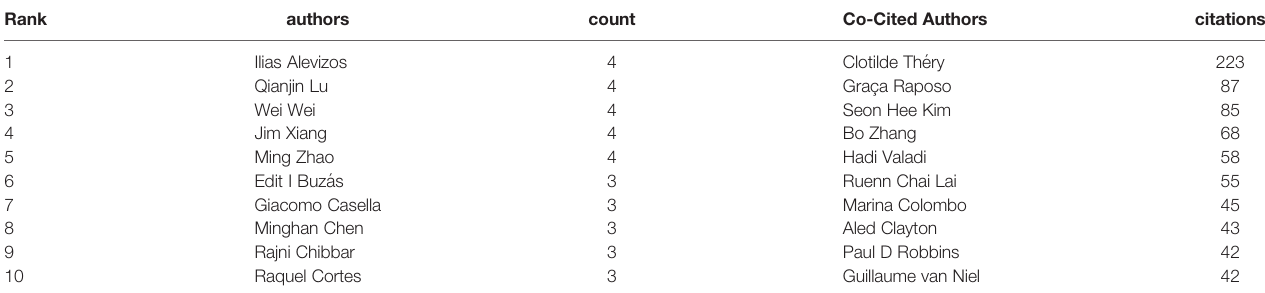
TABLE 3 | Top 10 authors and co-cited authors on research of exosomes in AIDs.